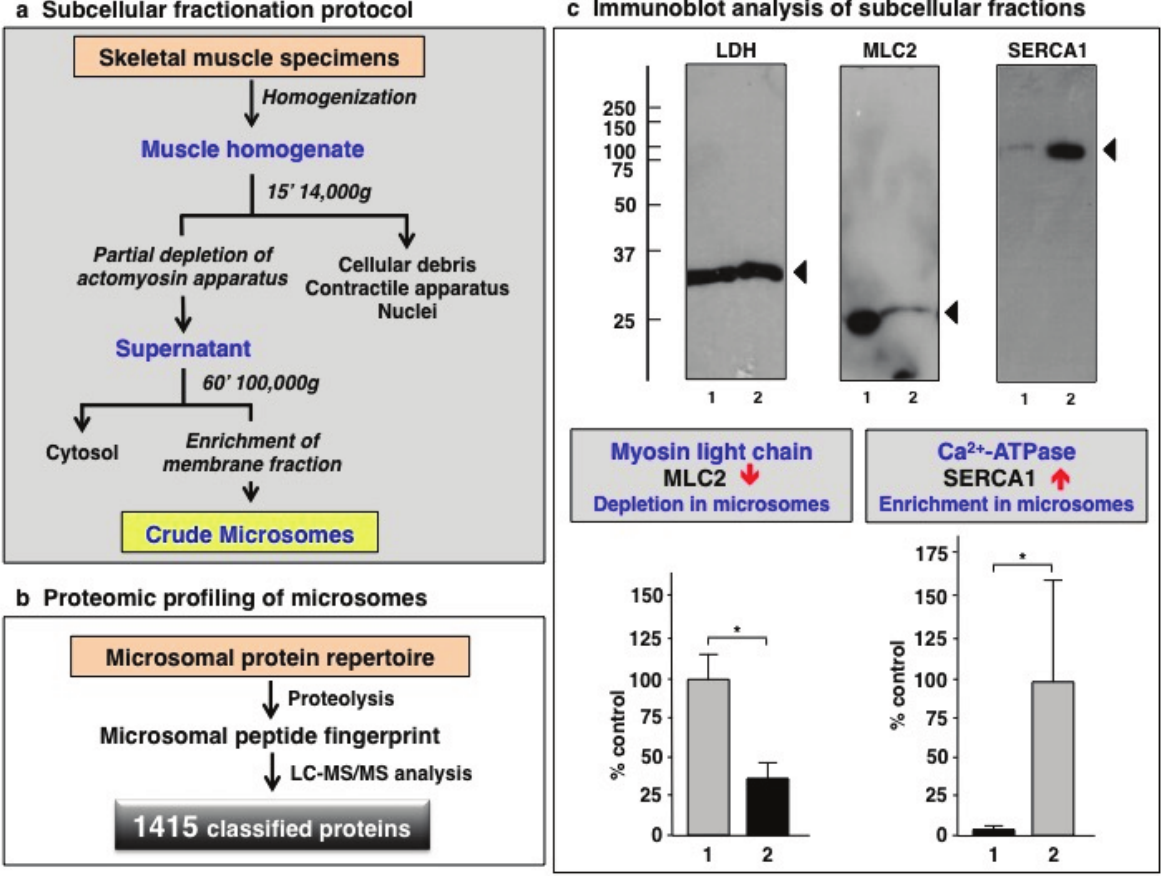
Figure 1. ( a ) Flowchart of the subcellular fractionation approach used in this proteomic study for the isolation of crude microsomes from skeletal muscle. ( b ) Overview of the mass spectrometric profiling of the microsomal subproteome. ( c ) Immunoblot analysis of lactate dehydrogenase (LDH; as loading control), myosin light chain isoform MLC2 and the sarcoplasmic reticulum Ca 2+ -ATPase isoform SERCA1. Arrowheads indicate immuno-labelled bands. Lanes 1 and 2 represent total muscle extracts and the microsomal fraction, respectively. Graphical presentations show the statistical analysis of immunoblotting of the contractile apparatus marker MLC2 versus the membrane fraction marker SERCA1 (Student’s t -test, unpaired; n = 4; * p <